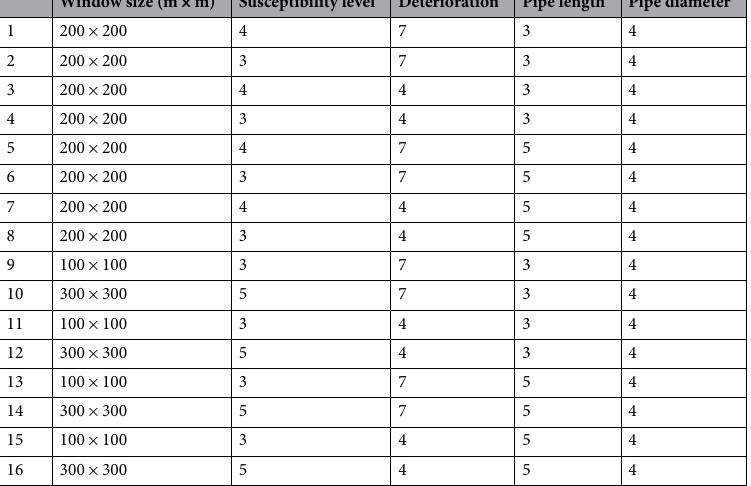
Table 7. Number of categories of factors used in machine